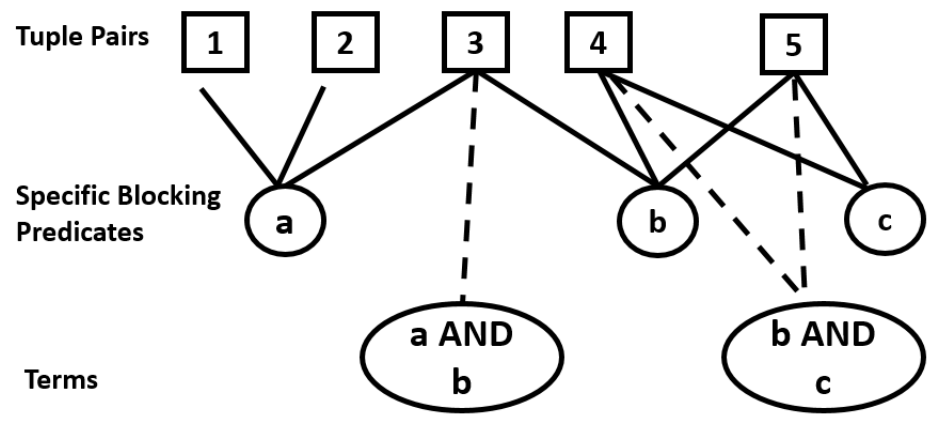
Figure 6. An example showing how H c is